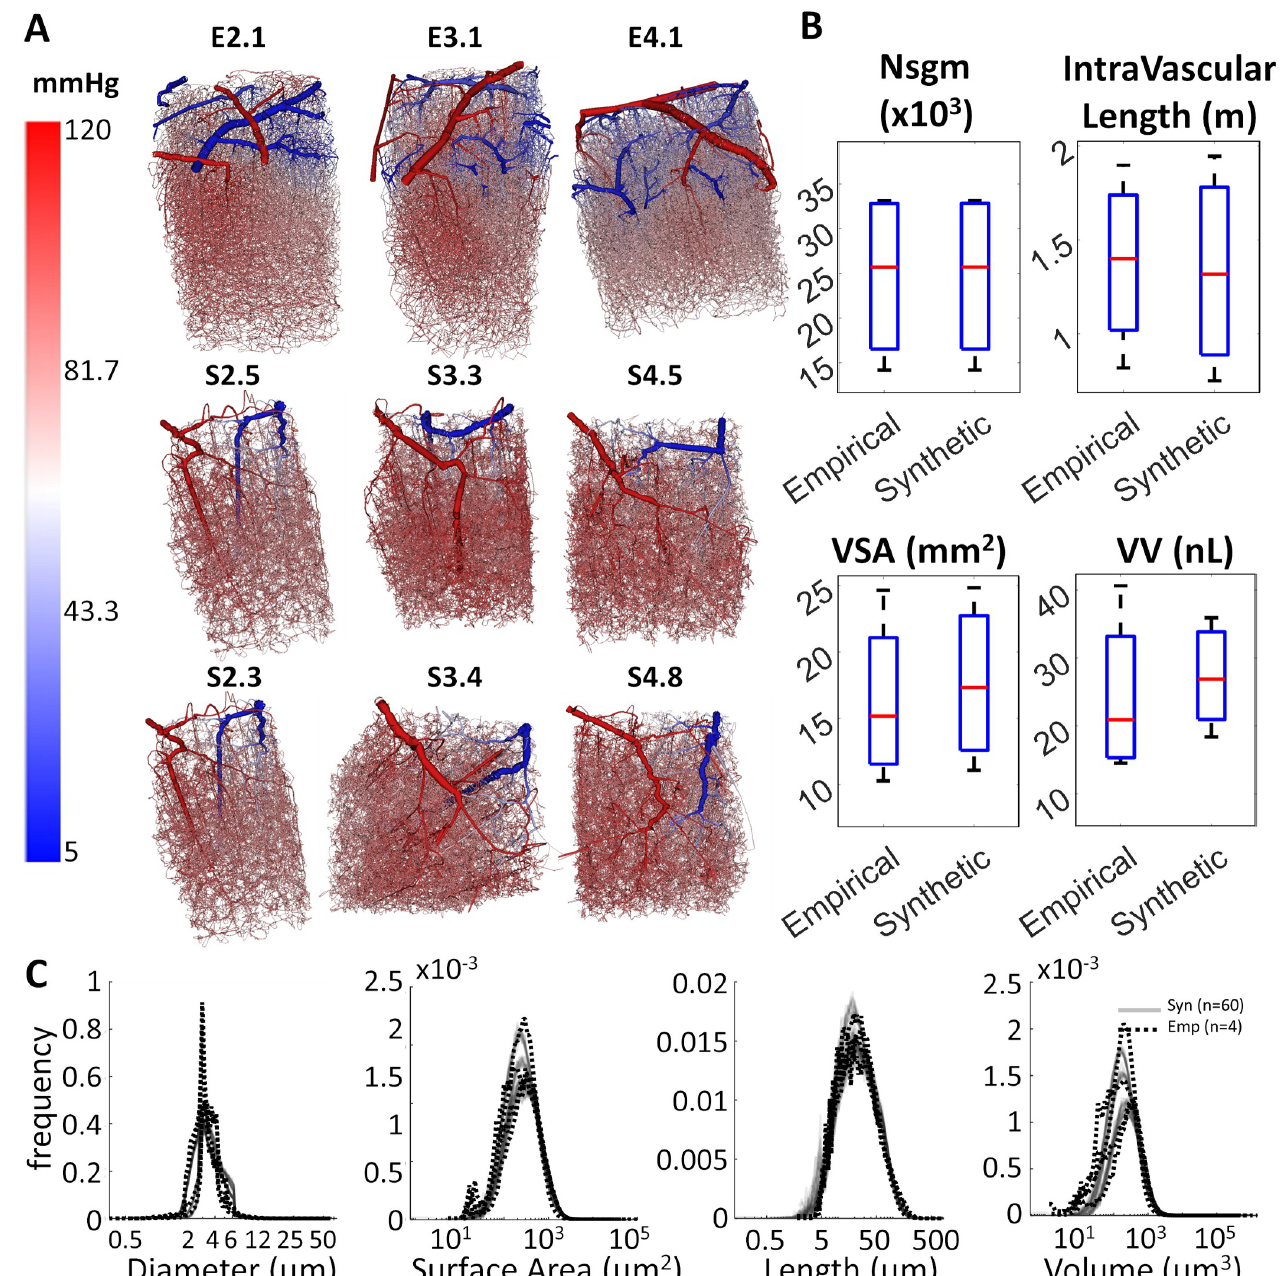
Fig 1. Morphometric comparison between experimental and synthetic microcirculatory networks from the murine vibrissa primary sensory cortex. (A) Three 2PLSM experimental [35] data sets (E2.1, E3.1, E4.1, three shown out of four) are compared to synthetic (S2.5, S3.3, S4.5, S2.3, S3.4, S4.8) microcirculatory networks (six shown, out of sixty total). (B) Cumulative microcirculatory morphometrics for experimental (N = 4) and synthetic (N = 60) networks (segment number-Nsgm, intravascular length, vascular surface area-VSA, and vascular volume-VV are statistically similar, p > 0.05 in all cases using one-way ANOVA). (C) Probability density functions show that the synthetic data sets are not identical, but match the topology of experimental data sets. Taken together, the morphometric analysis shows that experimental and synthetic networks are statistically